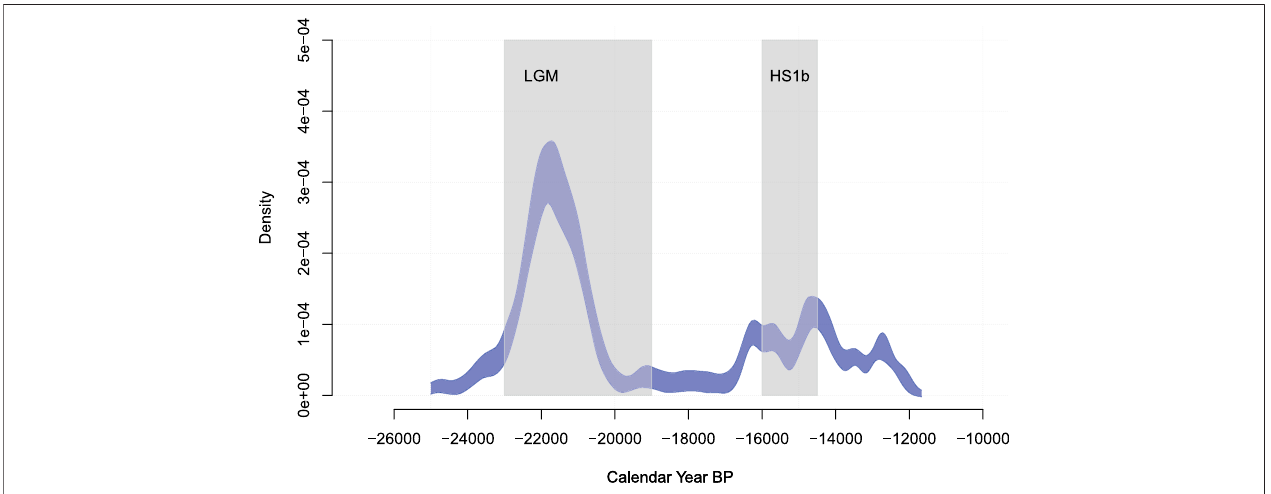
FIGURE4| KernelDensityEstimatesforallavailableradiocarbondatesassociateswithhumanoccupationattributedtotheLatePalaeolithic(see Supplementary Information c ). Created using the Rowcal package in R (McLaughlin, 2019).